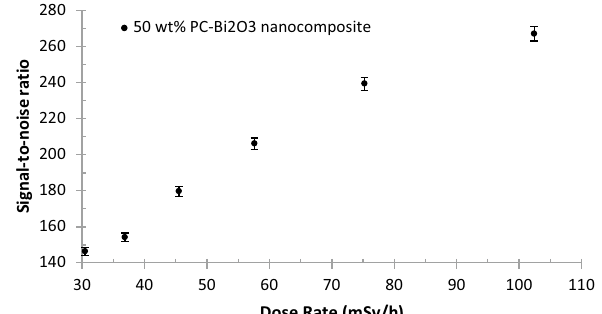
Figure 9. Signal-to-noise ratio of the 50 wt% PC–Bi 2 O 3 nanocomposite at 400 V against the beta-rays of 90 Sr with maximum standard deviation of 3.8% (1σ).